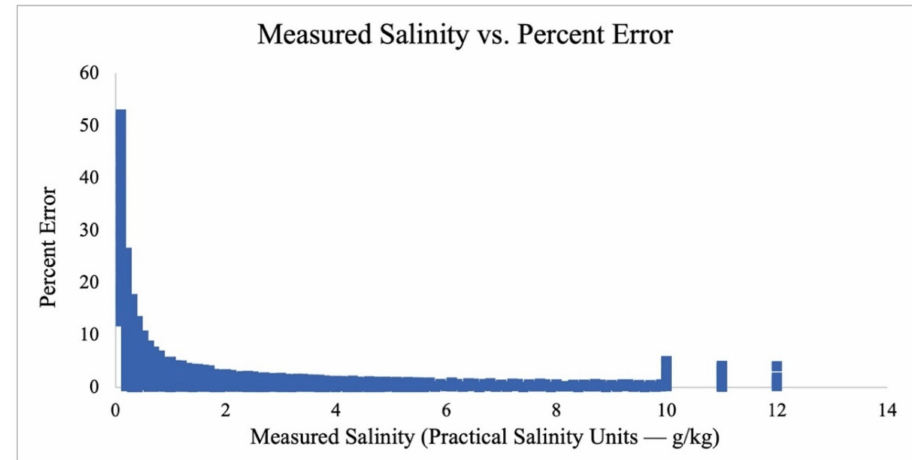
Figure A2. Plot of measured salinity against the percent error of salinity calculated from conductivity compared to the salinity directly measured at the same site (site 021720709) at the same time. Percent error is the difference between measured salinity and calculated salinity divided by the measured salinity. Data for conductivity and salinity were measured every hour throughout 2018. The full 2018 hourly dataset was used for this